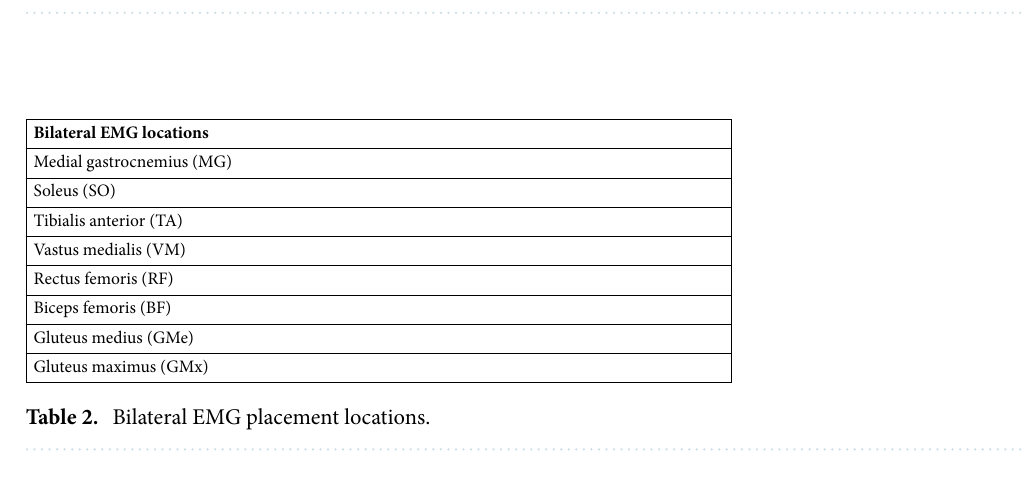
Table 1. Demographic information. Data include self-selected walking speed (SSWS), the lower extremity subscore of the Fugl-Meyer (FMA-LE) and peak ankle plantarflexor power (A2). *Indicates significant differences between groups per an alpha value of p < 0.05.